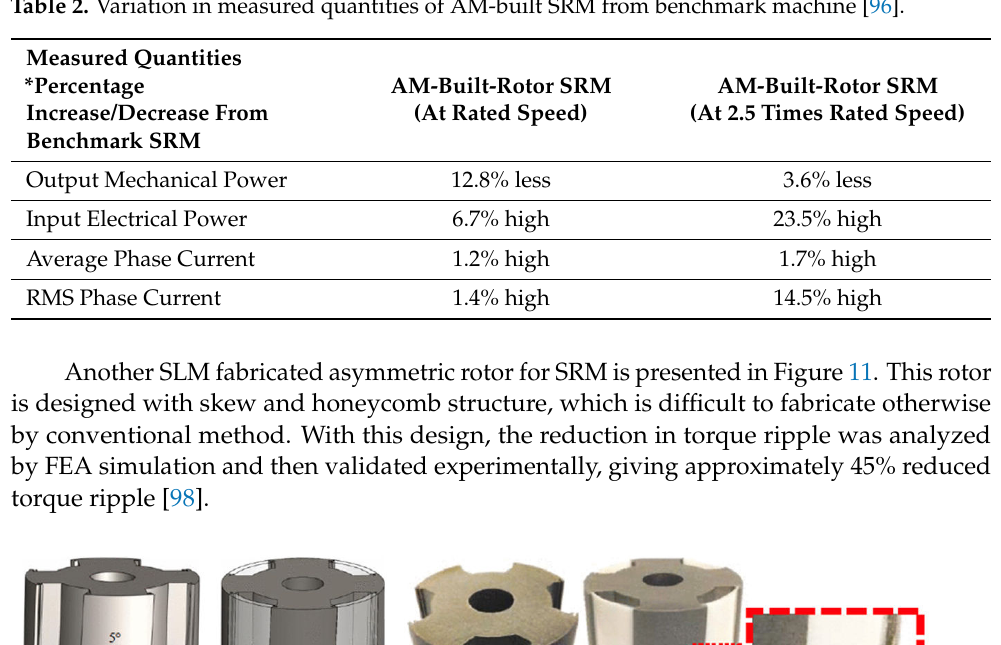
Figure 10. ( a ) Benchmark and Prototype AM-Built SRM-rotor ( b ) Torque –Speed characteristics of Benchmark and AM-built-rotor SRM [96,97]. Table 2. Variation in measured quantities of AM-built SRM from benchmark machine [96].